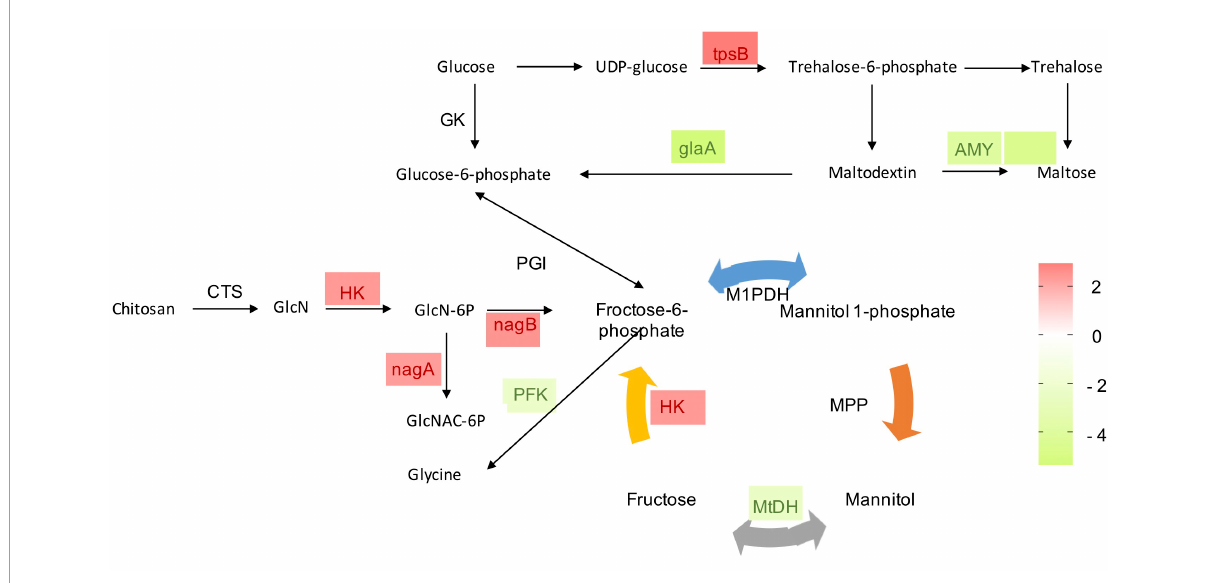
FIGURE7 Heat maps of differentially expressed genes (DEGs) that may be involved in sugar metabolism. GK, glucokinase; PGI, phosphoglucose isomerase; MtDH, mannitol-2-dehydrogenase; HK, hexokinase; M1PDH, mannitol-1-phosphate dehydrogenase; MPP, mannitol-1-phosphate phosphatase; tpsB, trehalose 6-phosphate synthase; AMY, alpha-amylase A; gLaA, glucoamylase; CTS, chitosanase; GlcN, glucosamine; GlcN-6P, glucosamine 6-phosphate; GlcNAc-6P, 6-phosphate- N -acetylglucosamine; nagA, 6-phosphate- N -acetylglucosamine deacetylation; nagB, 6-phosphate glucosamine deaminase; PFK, phosphofructokinase. The expression image was generated using GraphPad Prism software: red, increase; green, decrease.